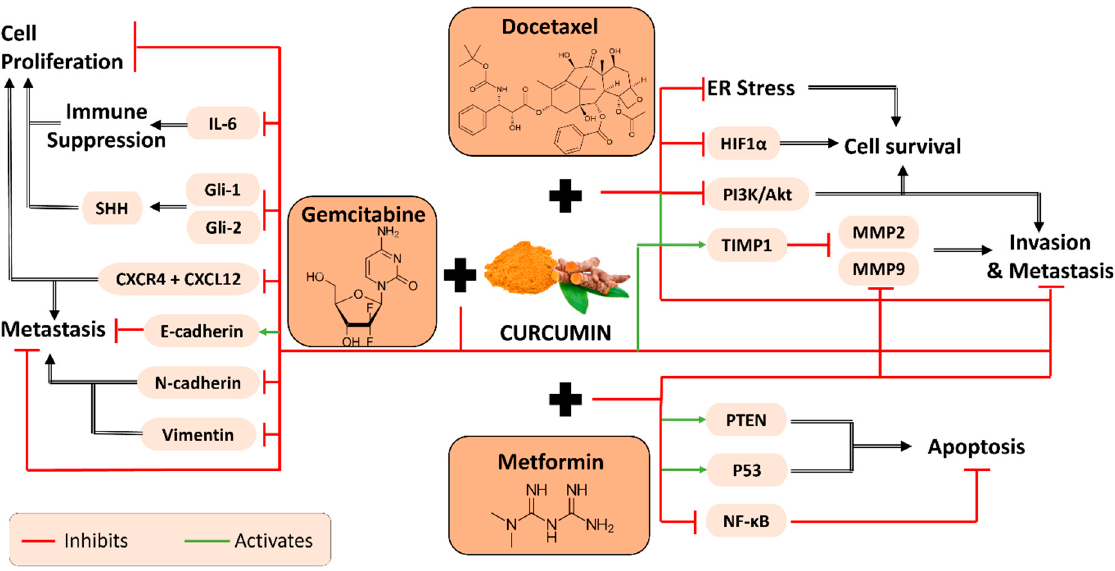
Figure 6. Molecular pathways underlying the anti-metastatic and anti-invasive properties of curcu- min in combination with each of the three chemotherapeutic drugs: docetaxel, metformin and gem- citabine.